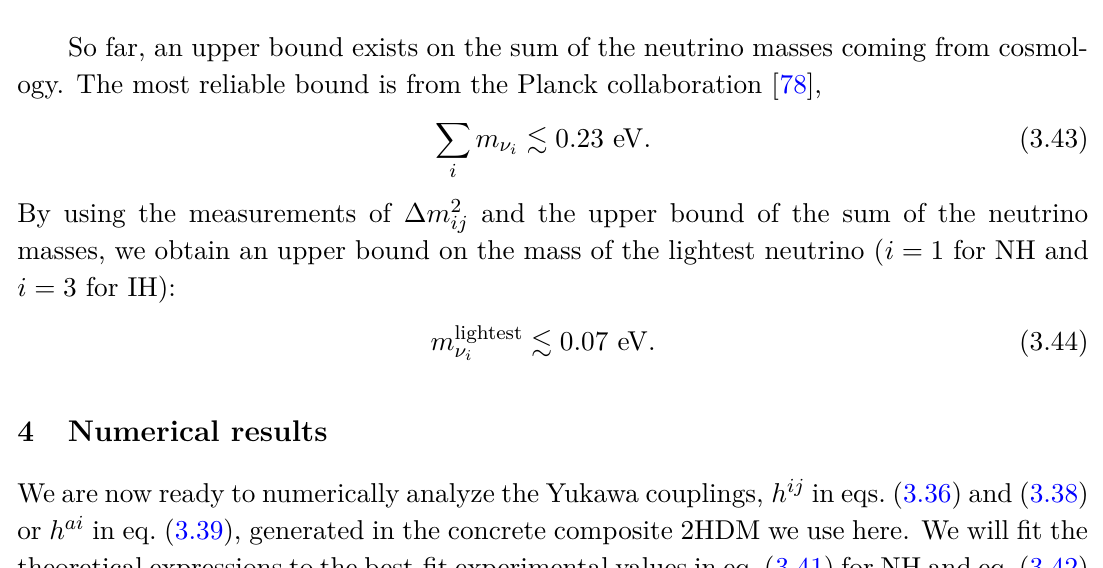
Figure 3 . Level of degeneracy ∆ η ≡ ( m R − m I ) /m I of the scalars in the neutrino mass loop as function of − C LR . The curves correspond to different values of s θ = 0 . 1 and 0 . 01 , and for different choices of the hyper-fermion masses: democratic m 1 = m 2 = m 3 , and m 3 = 0 . The degeneracy shows a mild dependence on the hyper-fermion